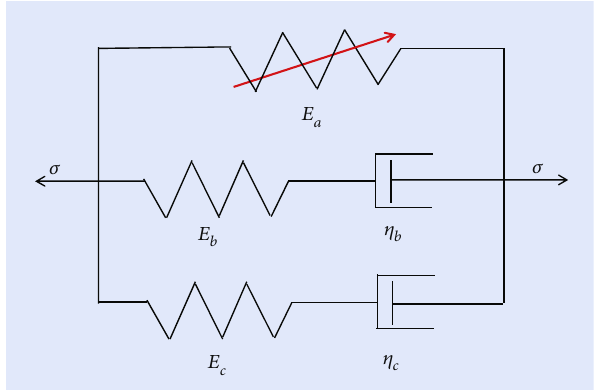
Figure 10: Z – W – T constitutive